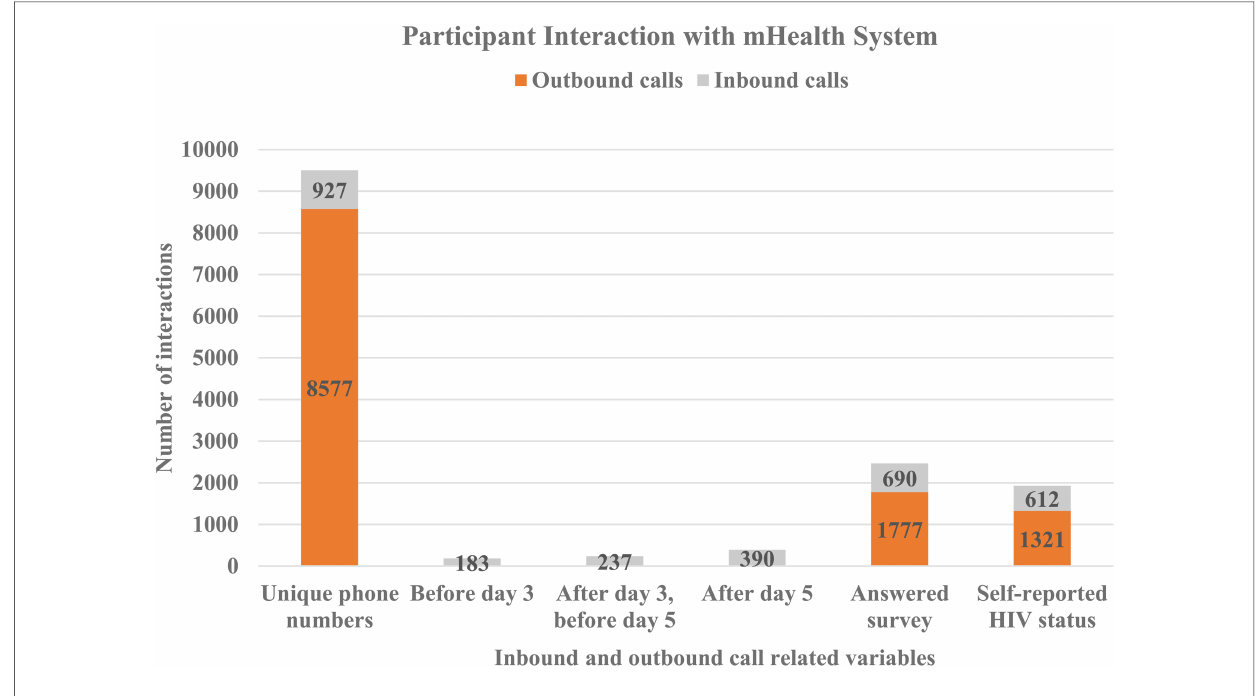
FIGURE 2 Participant survey